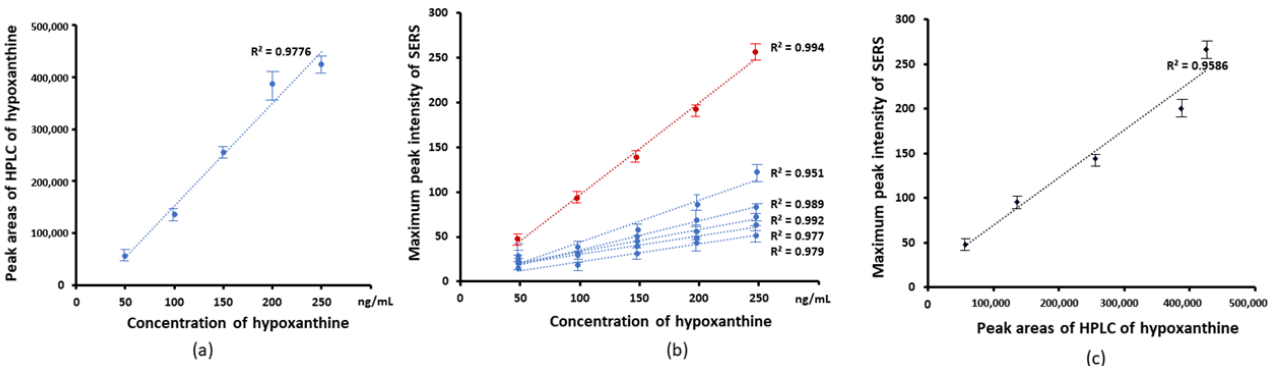
Figure 6. ( a ) The linear correlation of HPLC peak areas versus concentration of hypoxanthine ( b ) Correlation of SERS peak intensities versus concentration of hypoxanthine, from top to bottom. The maximum peak at 640, 1290, 560, 1620, 1206, 802 cm − 1 . The peak at ~640 cm − 1 (red line) showed an R 2 of 0.994. ( c ) The correlation of 640 cm − 1 maximum peak intensity vs . peak areas of HPLC for hypoxanthine. R 2 is 0.959.